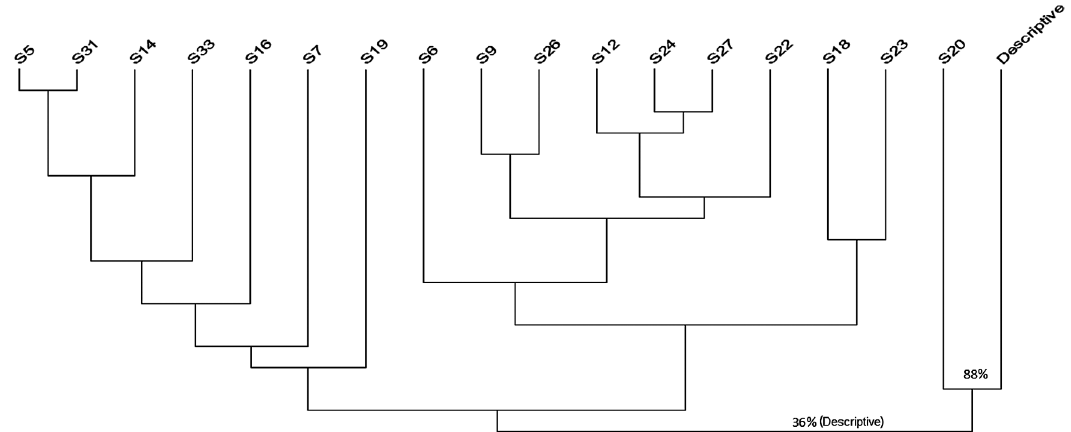
FIG. 2. Similarity tree of real students ( s i ) in relation to the descriptive ideal student profile. Numbers represent the CHIC generated similarity levels between student clusters and the ideal